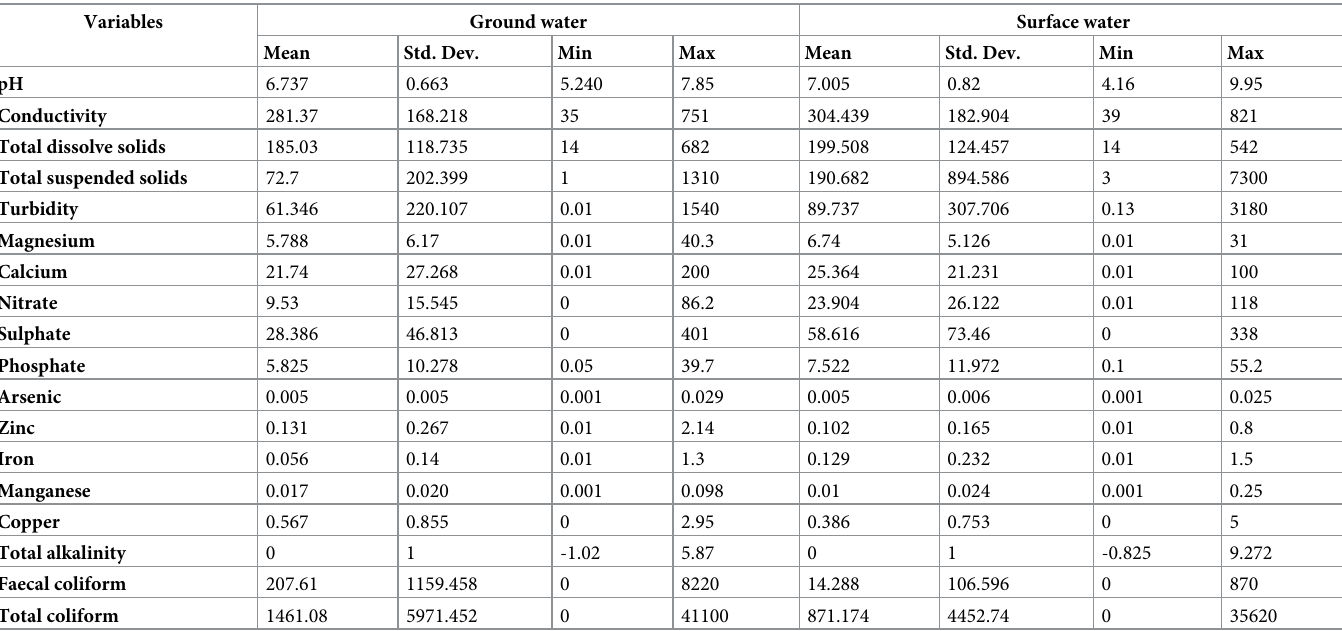
Table 1. Statistical summary of predictors and explanatory